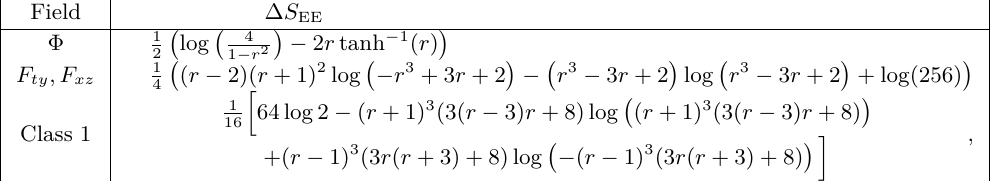
Table 2 . Growth of entanglement entropy for scalars under SO(2) T × SO(2) L . , here r = y 0 /t .